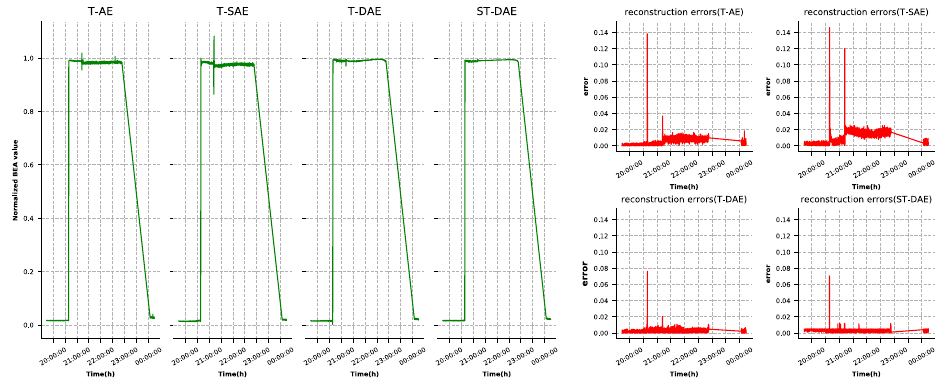
Figure 7. BEA reconstruction results and